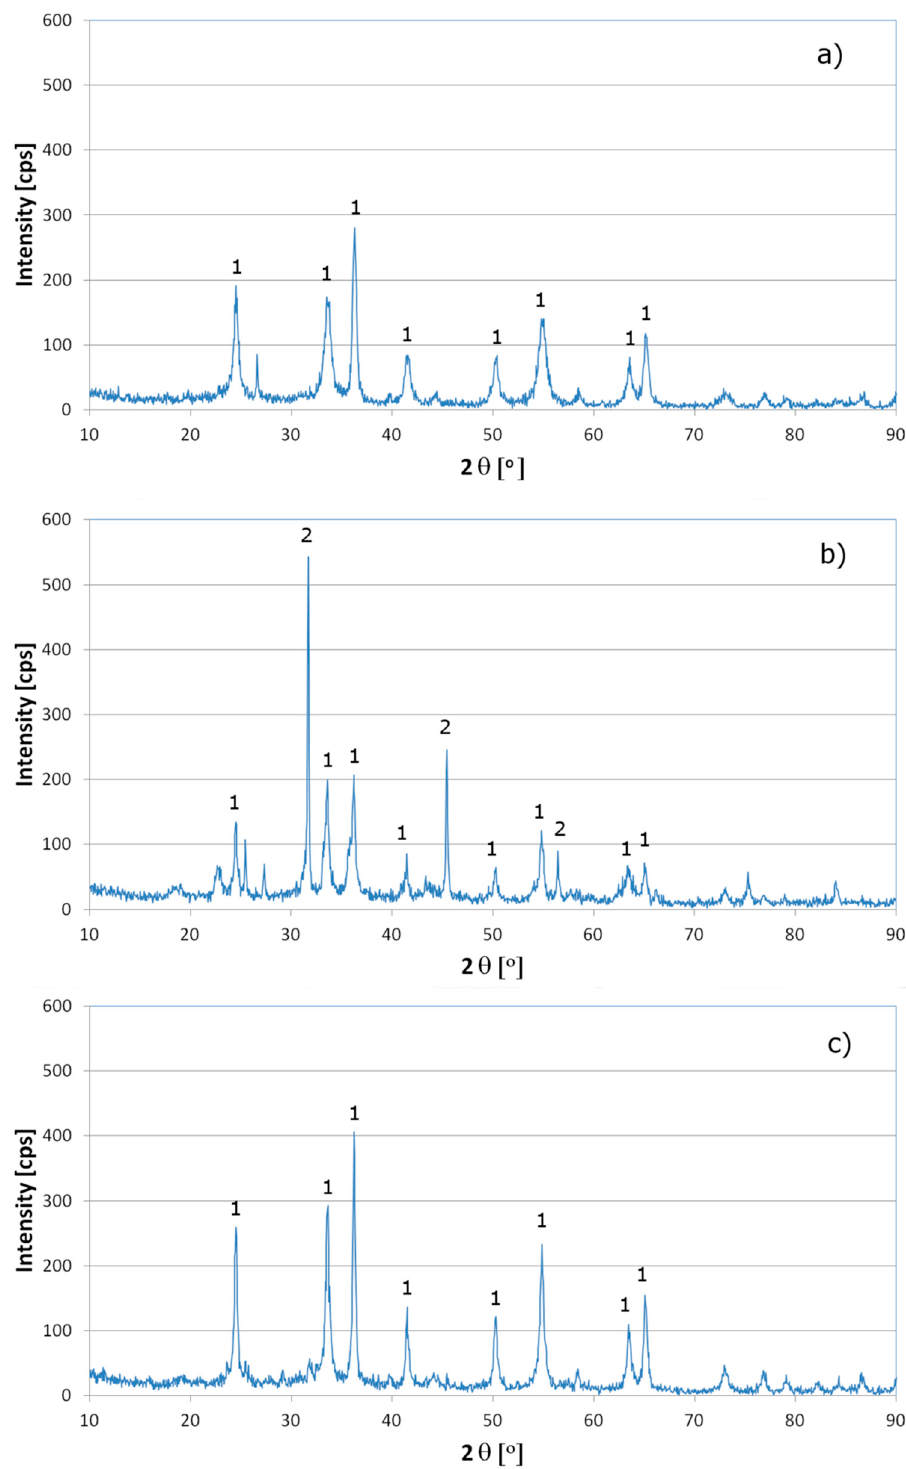
Figure 3. X-ray di ff raction (XRD) powder di ff raction patterns of tannery waste ash samples: ( a ) tanned Figure 3. X-ray diffraction (XRD) powder diffraction patterns of tannery waste ash samples: ( a ) trimmings; ( b ) shavings; ( c ) mixture of leather trimmings, shavings and bu ffi ng dust, in a weight ratio tanned trimmings; ( b ) shavings; ( c ) mixture of leather trimmings, shavings and buffing dust, in a of 2:2:1 (1—Cr 2 O 3 ; weight ratio of 2:2:1 (1—Cr 2 O 3 ; 2—NaCl).